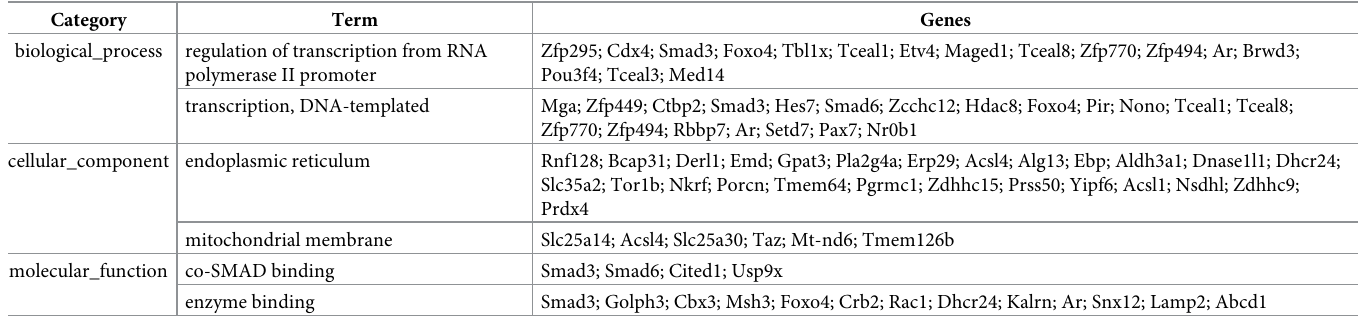
Table 2. Diabetic-vs-control-CCGG.Diff.GO-classification.